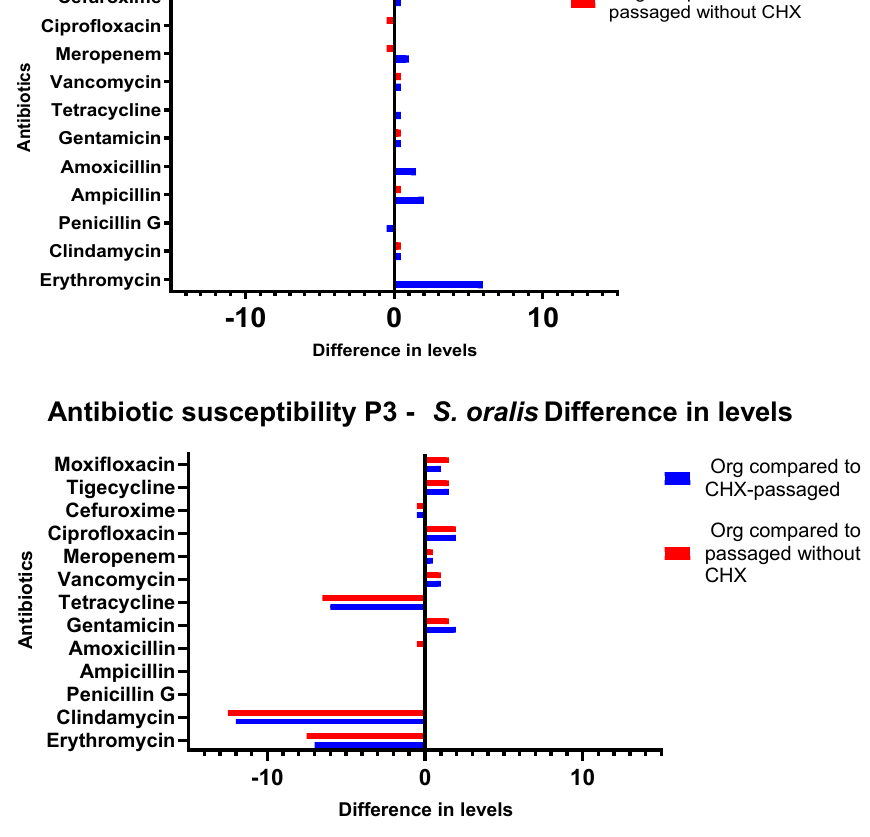
Figure 5. Antibiotic susceptibility testing of S. oralis isolates from Subject 1–Subject 3. Graphical depiction of the difference in susceptibilities in levels between the original isolate and the isolates after passaging with and without CHX. The levels are drawn on the X-axes, and the antibiotics are shown on the Y-axes. P1–P3: Probands 1–3.